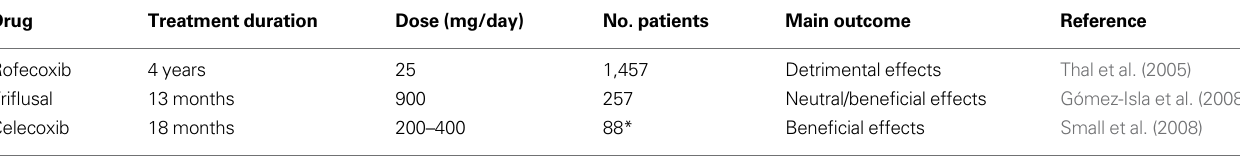
Table 3 | Double-blind, randomized, placebo-controlled trials of NSAIDs in patients with MCI. Drug Treatment duration